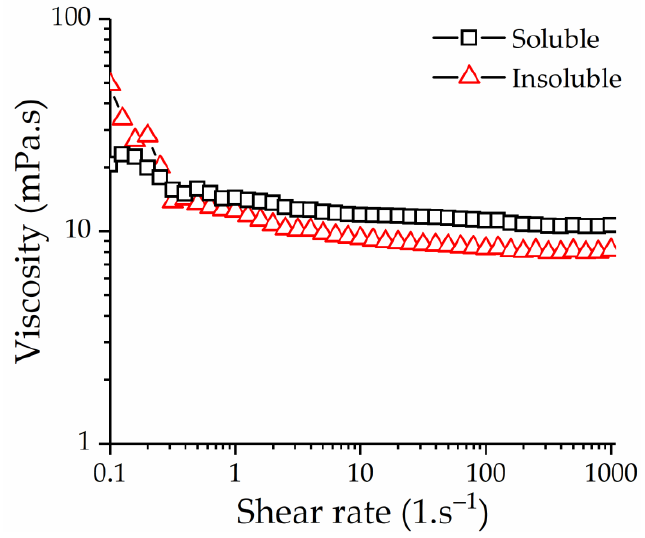
Figure 5. The apparent viscosities of β -glucan at various shear rates with a concentration of 3.0% ( w / v ) at 25 °C. Soluble, water- soluble β -glucan; Insoluble, water- insoluble β -glucan.